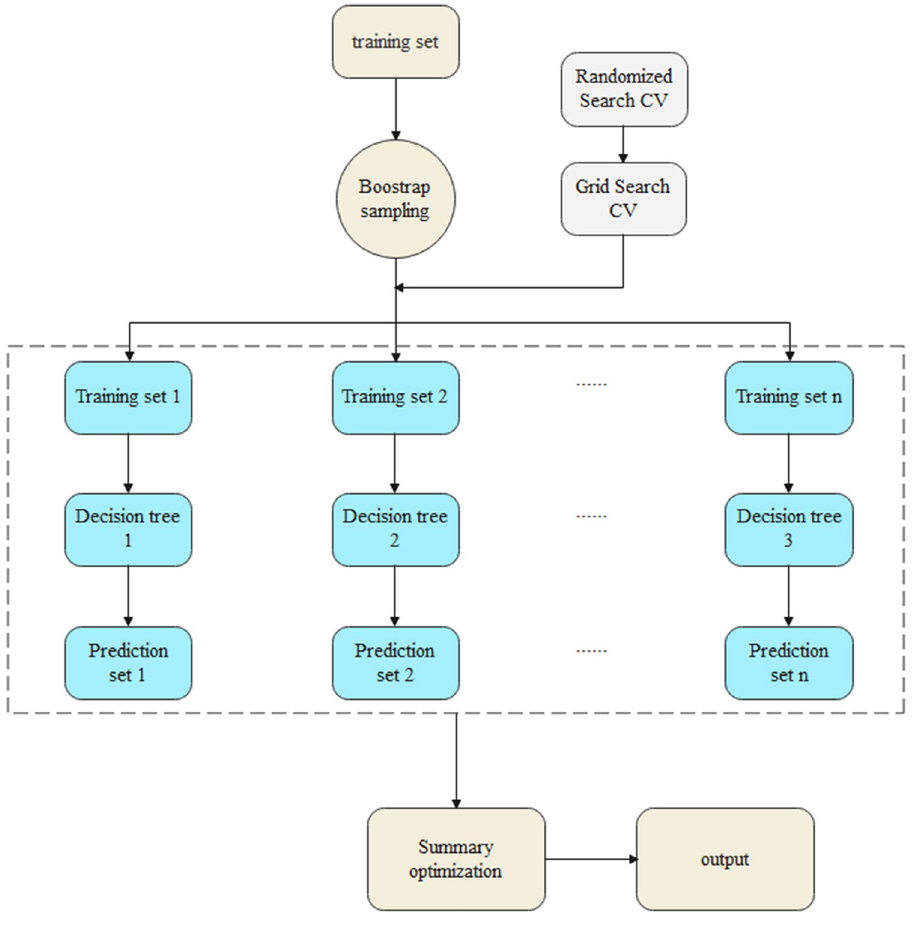
Figure 4. Flow chart of random forest